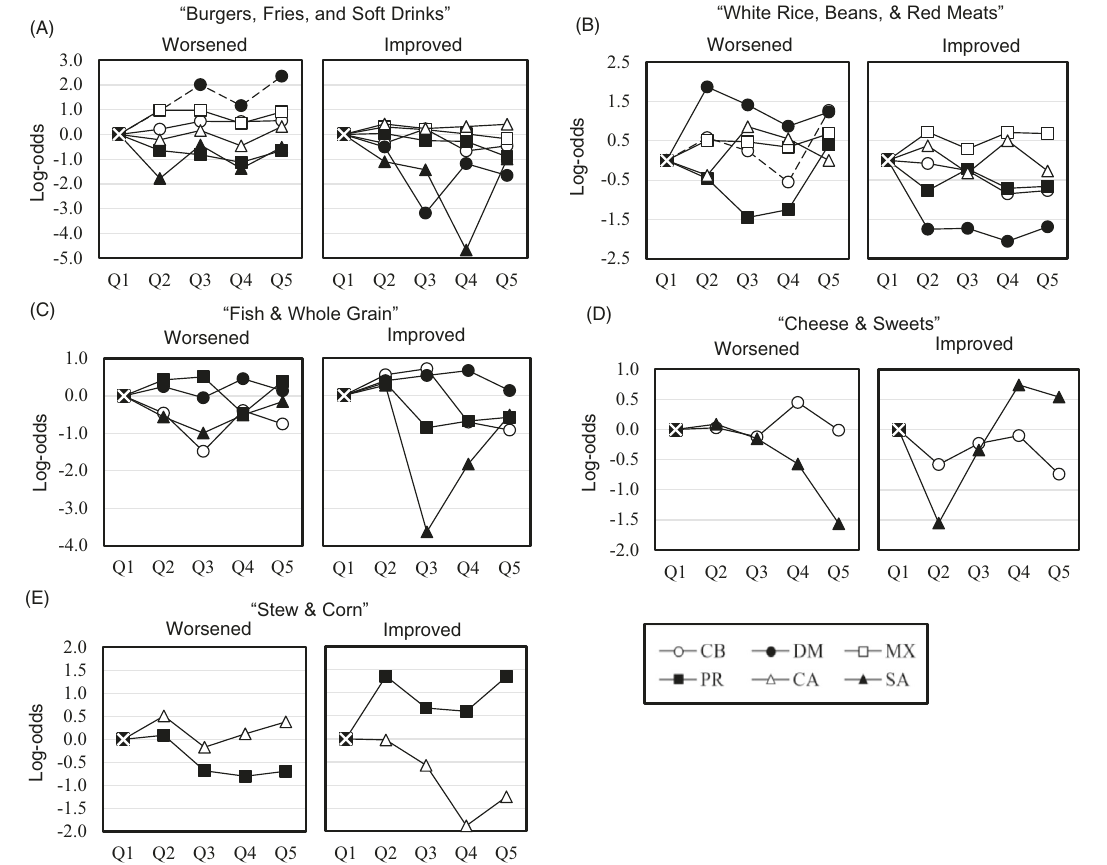
Fig. 2 Six-year likelihood of worsened or improved (versus unchanged) insulin resistance status comparing highest-to-lowest quintiles of heritage-speci fi c a posteriori dietary patterns for each overarching dietary pattern identi fi ed in HCHS/SOL a . ªLikelihood estimates are log- odds of worsened and improved (versus unchanged) insulin resistance status by heritage-speci fi c a posteriori dietary patterns for each overarching dietary pattern identi fi ed in HCHS/SOL among the following heritage groups: Cuban (CB, n = 1173), Dominican (DM, n = 682), Mexican (MX, n = 3354), Puerto Rican (PR, n = 1068), Central American (CA, n = 876), South American (SA, n = 621). All models were survey weighted. Change in insulin levels was fi rst calculated using the difference between visit values (visit 2 − visit 1) and then categorized (after showing no evidence of skewness) using a change in standard deviation (SD) to re fl ect ( ≤ − 1 SD), unchanged ( − 1 > SD < 1), or worsened ( ≥ 1 SD) insulin resistance status at 6 years. Models adjust for elapsed time between visits (years) and relevant baseline covariates, including age (years), sex (male, female), self-reported highest education achieved (<high school, high school or equivalent, >high school), nativity (US- born (US states only), foreign-born), total energy intake (kJ/day, natural log of baseline fasting insulin (pmol/L), and baseline self-reported physical activity level (low, moderate/vigorous) based on days and total metabolic equivalents (minutes/day) assessed using a modi fi ed Global Physical Activity Questionnaire, which asks about activity and inactivity (i.e. sedentary behavior) in several life domains (work, travel, leisure). P trend values were calculated by including the midpoint of each quintile of each heritage-speci fi c a posteriori dietary pattern as a continuous variable (score units). Dashed lines indicate signi fi cant linear trends and differences between highest-to-lowest quintiles at P < had among the lowest diet quality scores other heritage groups (Supplementary Fig. 3), potentially explaining the signi fi cantly higher risk of diabetes in this group. We also found that the “ Burger, Fries, & Soft Drinks ” DP remained associated with diabetes risk among the Puerto Rican heritage group, even after accounting for WC. Also, this suggests that other mechanisms could contribute to the development of diabetes, independent of adiposity. For example, in the Boston Puerto Rican Health Study [39], Mattei and colleagues showed that a DP similar to our “ Burger, Fries, & Soft Drinks ” DP was associated with higher allostatic load, a risk factor for diabetes, independent of BMI. These fi ndings suggest as health risk associated with a “ Burger, Fries, & Soft Drinks ” DP beyond its impact on adiposity, at least in those of Puerto Rican heritage. By contrast, the Cuban “ Cheese & Sweets ” dietary pattern was signi fi cantly associated with reduced diabetes risk only after adjusting for WC, suggesting a similar health risk beyond central adiposity for individuals of Cuban heritage. Future work, however, is needed to verify our fi ndings.